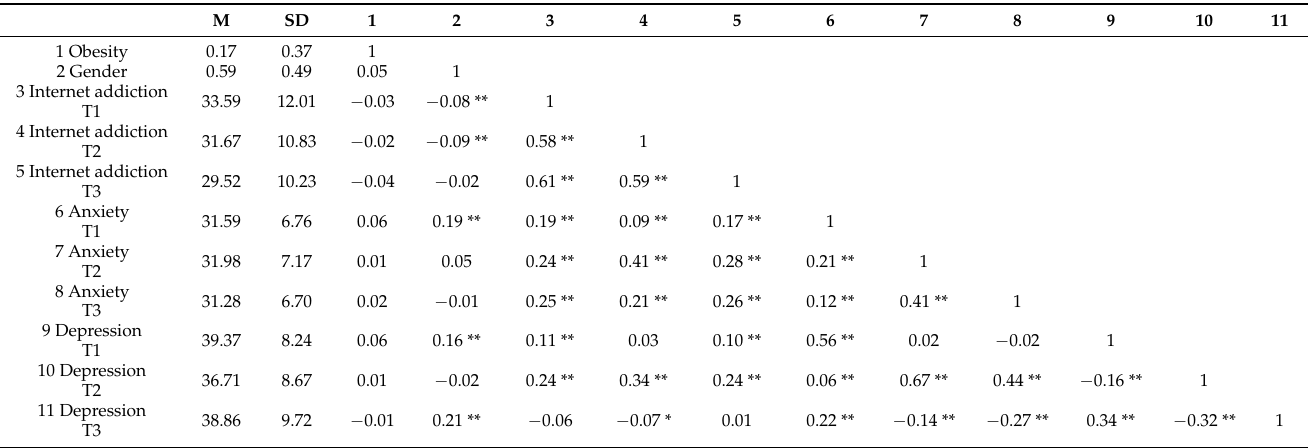
Table 2. Mean value, standard deviation, and correlation coefficient of each variable.